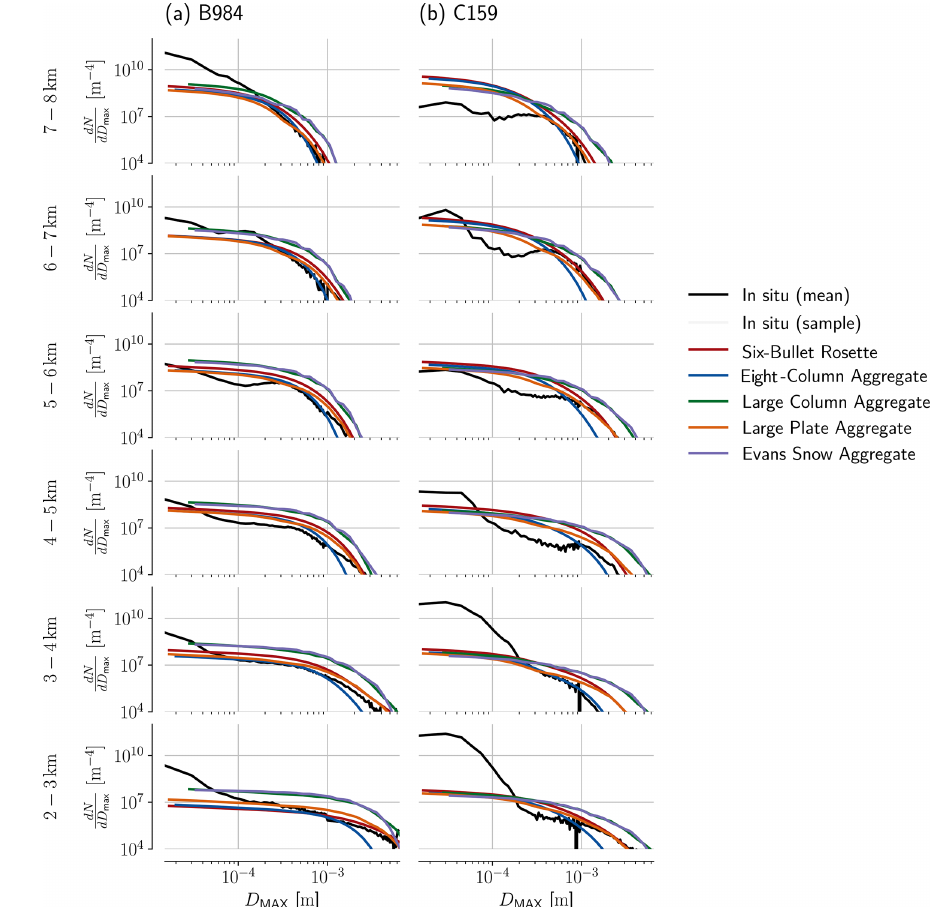
Figure 14. In situ-measured and retrieved PSDs for flights B984 (left column) and C159 (right column). Each row of panels shows the mean of the in situ-measured PSDs (black) together with randomly drawn samples of measured PSDs (light grey) for a given altitude bin of a height of 1km. Colored lines on top show the corresponding mean retrieved PSD for different assumed particle